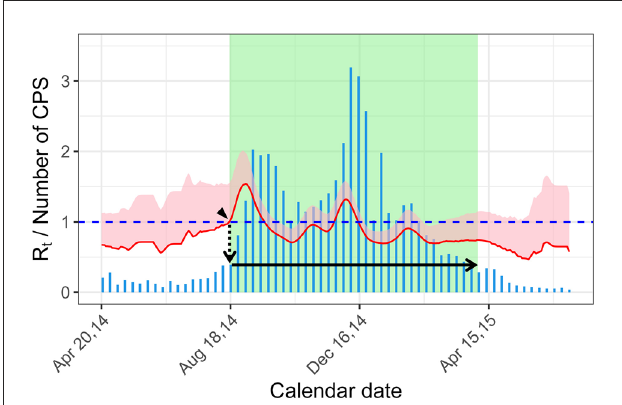
FIGURE1 Definition of the epidemic period using the effective reproduction number. The start of the epidemic period is the time when the lower bound of the 95% CI became > 1 (arrow head). The epidemic threshold of the year is the numbers of cases at the start of the epidemic period (dotted arrow). The end of the epidemic period is time when the number of cases is below the epidemic threshold (solid arrow). The bar graph (blue) shows the weekly CPS. The effective reproduction number is shown with 95% CI band (pink shade) and its lower bound (red line). Green rectangle shade shows the epidemic period. R t , effective reproduction number; CPS, case per